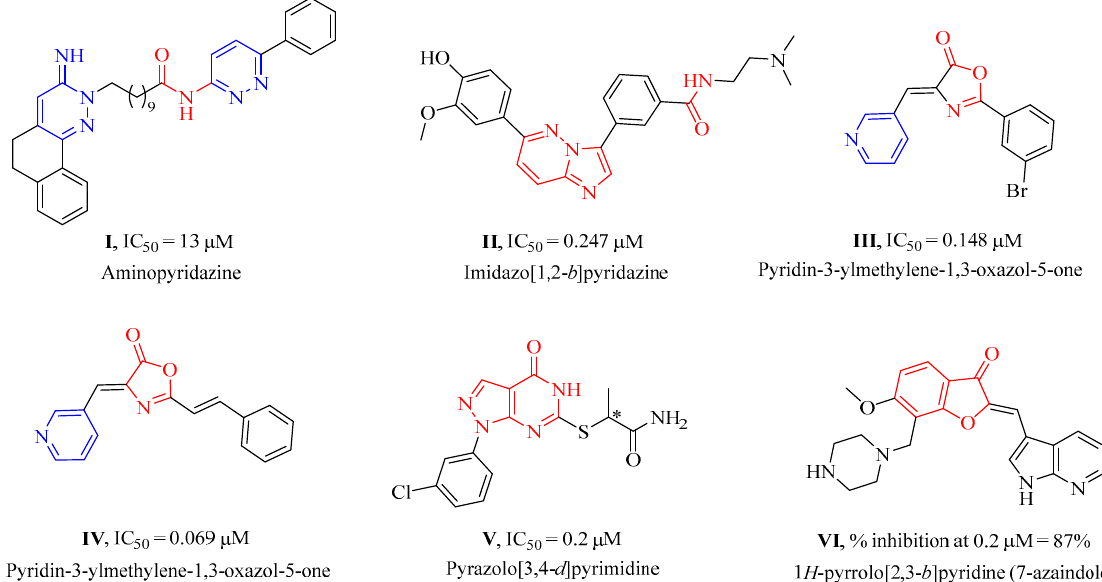
Figure 1. Reported synthetic small molecules bearing different chemical scaffolds and their IC 50 values or % inhibition against DAPK1 kinase.